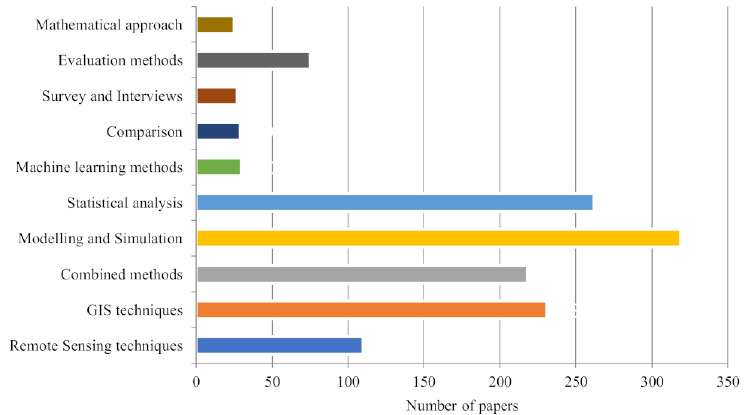
Figure 3. Number of papers per research